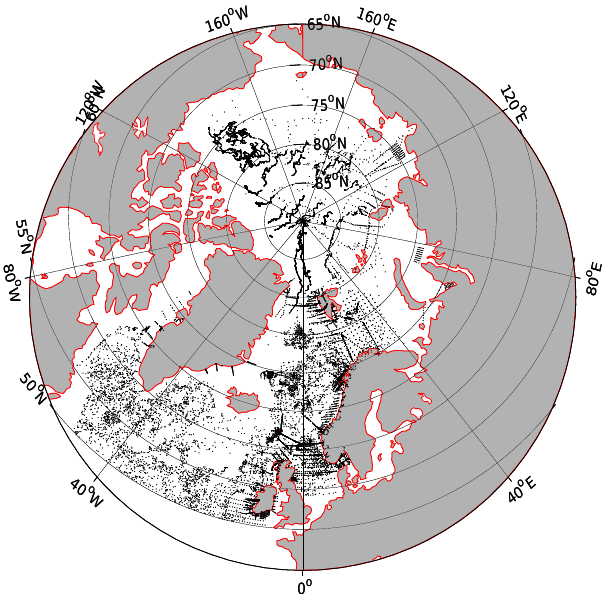
Fig. 4. The map of locations of assimilated in-situ observations north of 50N for the period from April 2007 to December